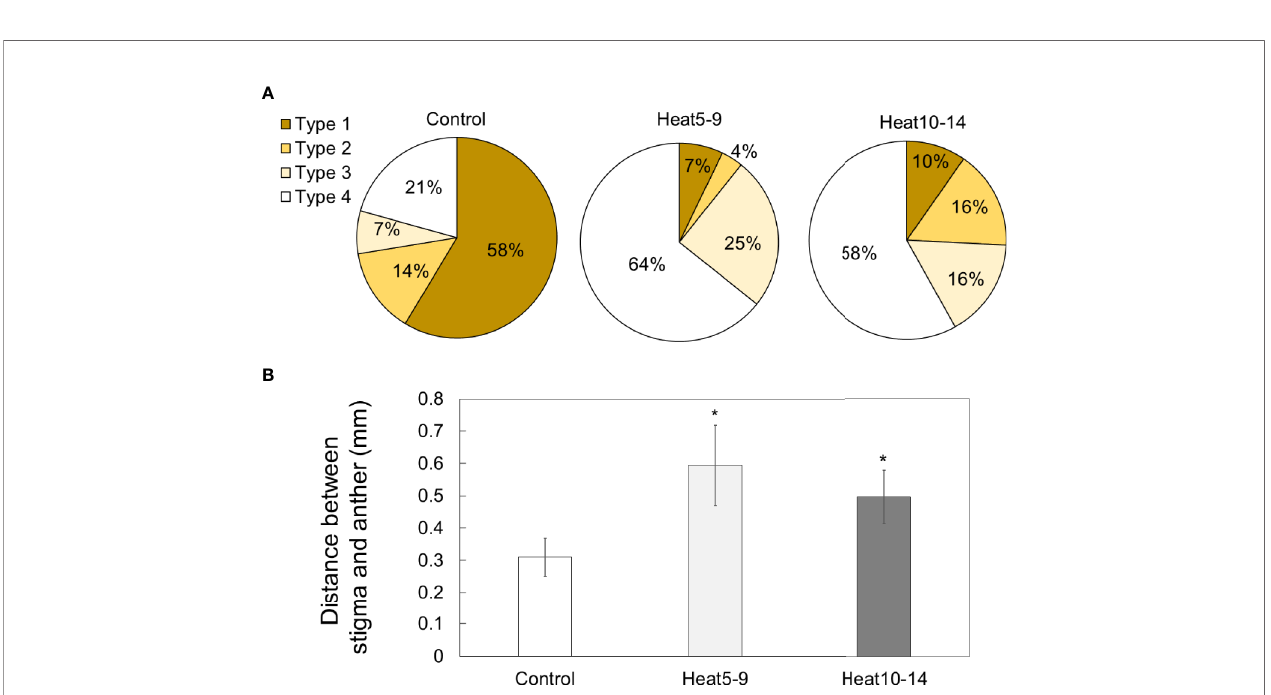
FIGURE 3 | Analysis of pollen attachment patterns to the stigma and distance between anthers and stigma in fl owers of Arabidopsis plants (Columbia-0). (A) Stigmas were classi fi ed into four types based on the pollen attachment patterns (refer to Supplementary Figure S2 ) and proportion of each type of stigma relative to total number of stigmas was calculated. (B) Distance between anthers and stigma grown under controlled or heat stressed conditions. Bars indicate Standard error. *, Student t -test signi fi cant at p < 0.05 compared to control (n = 13 –